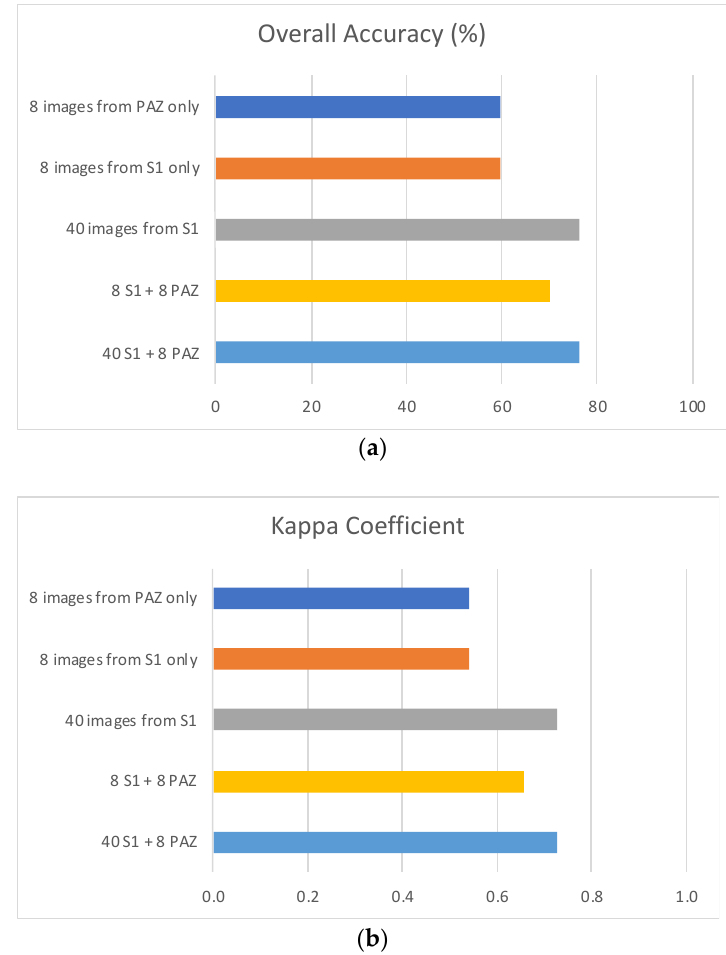
Figure 6. OA ( a ) and kappa ( b ) bar charts comparing all five experiments.